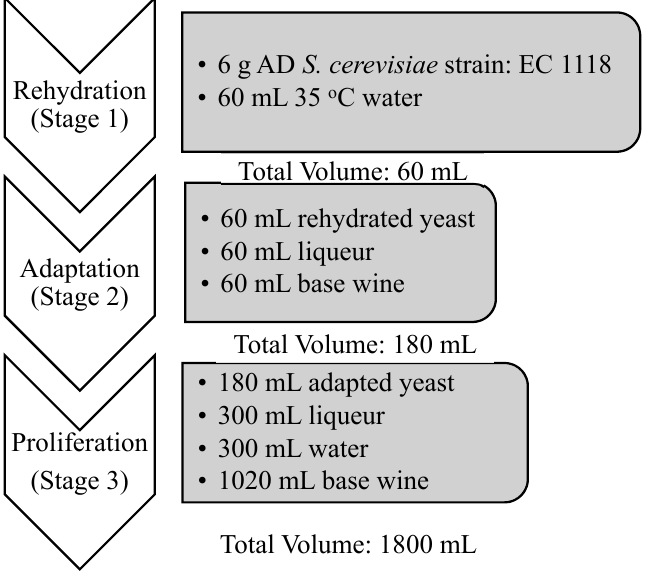
Figure 1. The yeast acclimatization protocol.